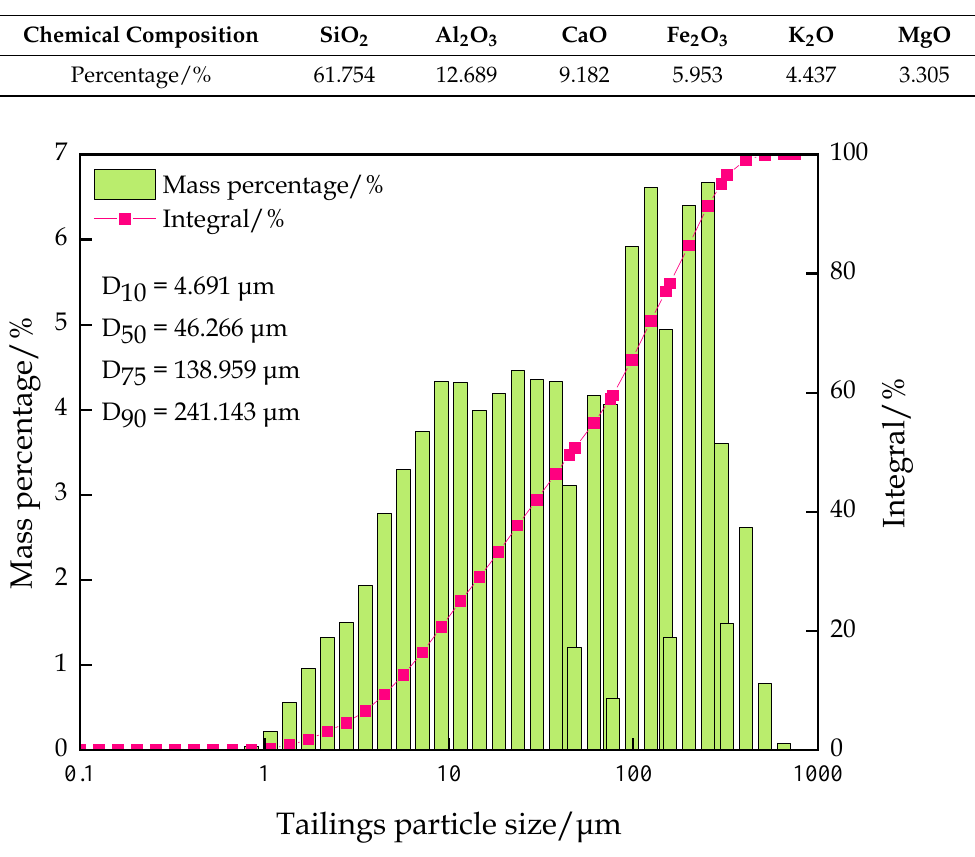
Figure 1. Particle size distribution diagram of classified fine tailings.